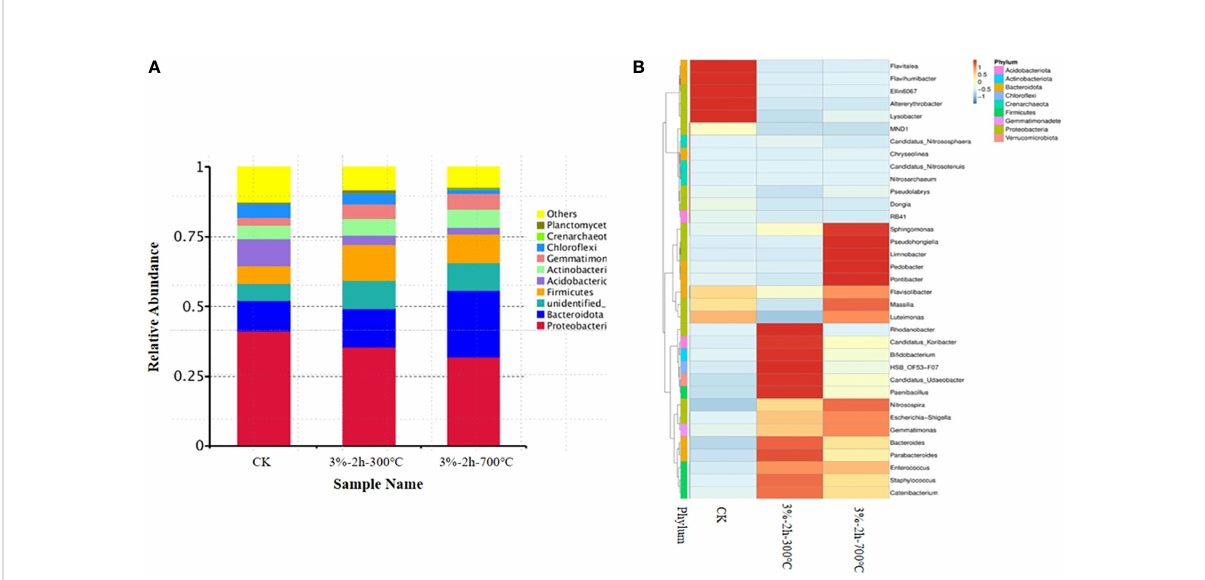
FIGURE 6 Comparison of soil microbial community structure before and after application of water hyacinth biochar. (A) Bacterial communities are formed at the phylum level. (B) Cluster analysis of species at the phylum